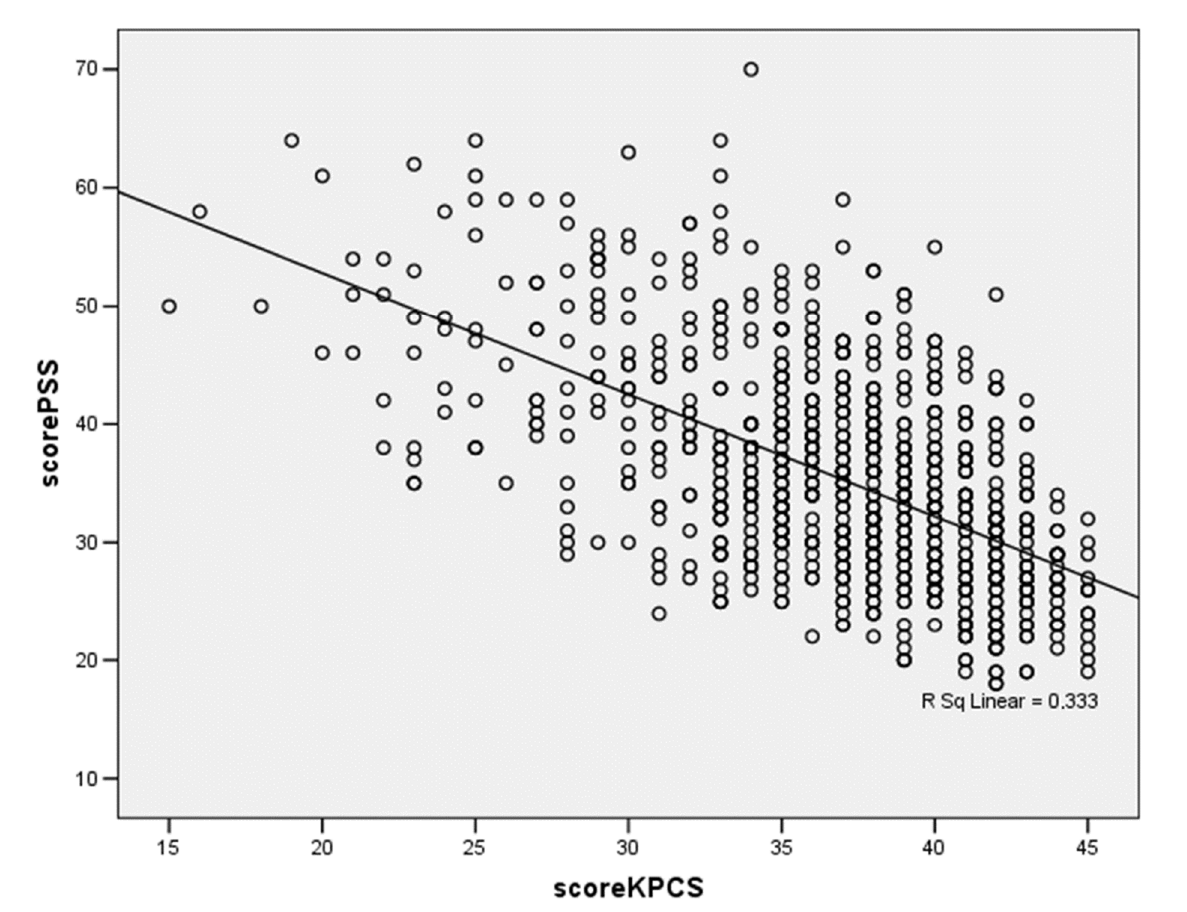
Figure 1. Bivariate analysis: scatter-plot between the PSS-IT and KPC-IT scores.